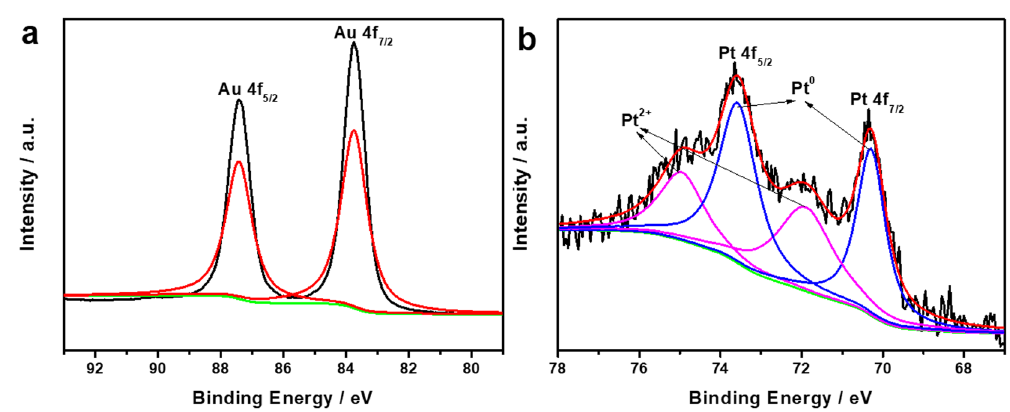
Figure 4. High-resolution XPS spectra of ( a ) Au 4 f and ( b ) Pt 4 f of AuPt